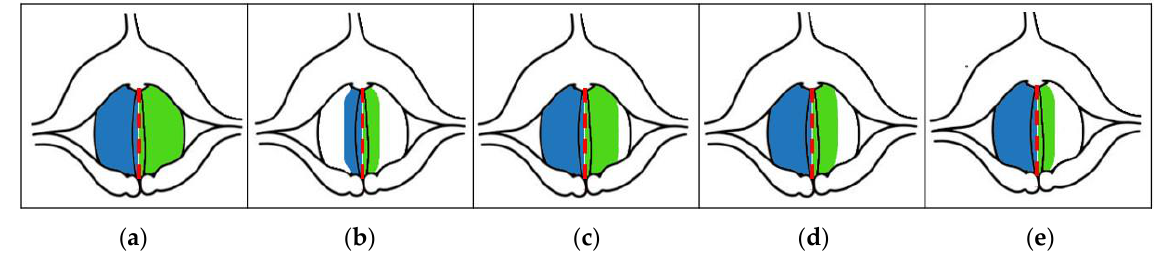
Figure 5. Illustration of the detected different size regions of the vocal folds vibrating at the fundamental frequency indicated by the different values of SAI and the corresponding values of the parameter (approximate values), ( a ) SAI = 0.0, ( b ) SAI = 0.0, ( c ) SAI = 0.25, ( d ) SAI = 0.5, ( e ) SAI = 0.75 [38]. The red dashed line marks the axis of symmetry of the glottis, and the blue and green areas correspond to the detected areas of vibration of the right and left vocal folds, respectively.